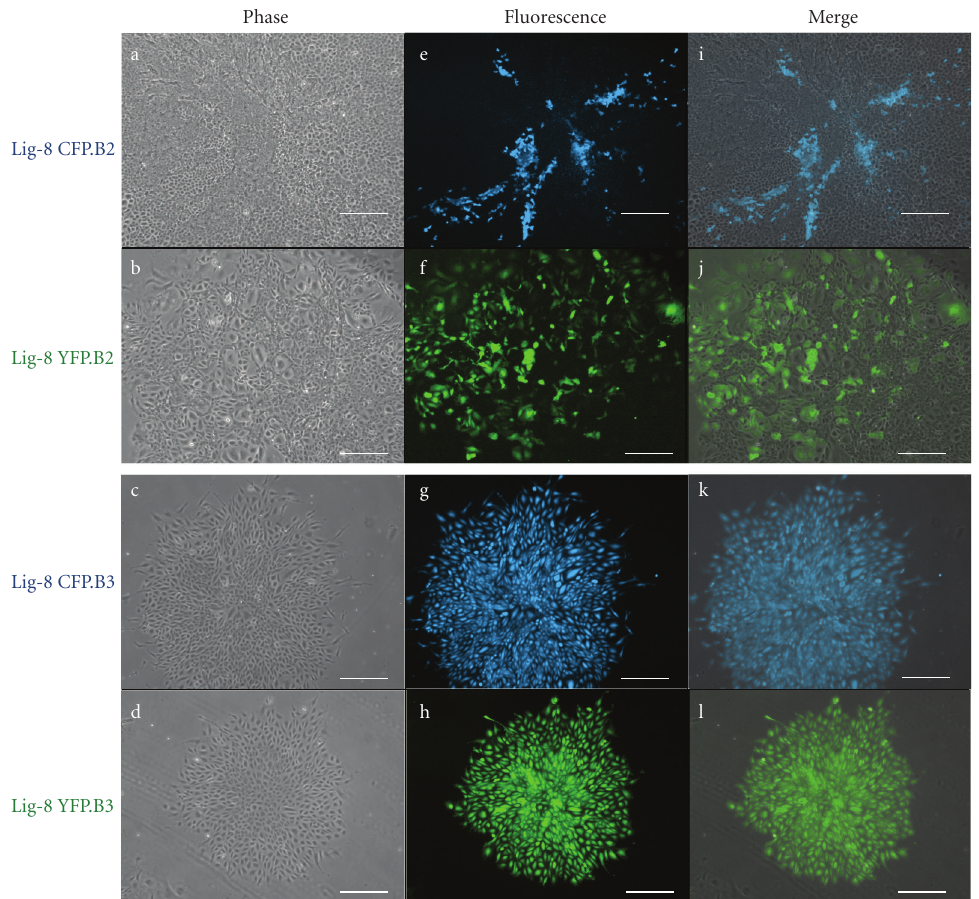
Figure 3: Fluorescent protein (CFP or YFP)-expressing colonies from rat hepatic ASCs. Rat hepatic ASC strain, Lig-8, was stably transfected with either a CFP or YFP expression vector. Shown are colonies with approximately 20–75% of the cells expressing (B2) and colonies with essentially 100% of the cells expressing (B3). Shown are the phases (a)–(d), fluorescent (e)–(h), and merged (i)–(l) images of CFP- and YFP-expressing colonies. Scale bar is equivalent to 100 μ